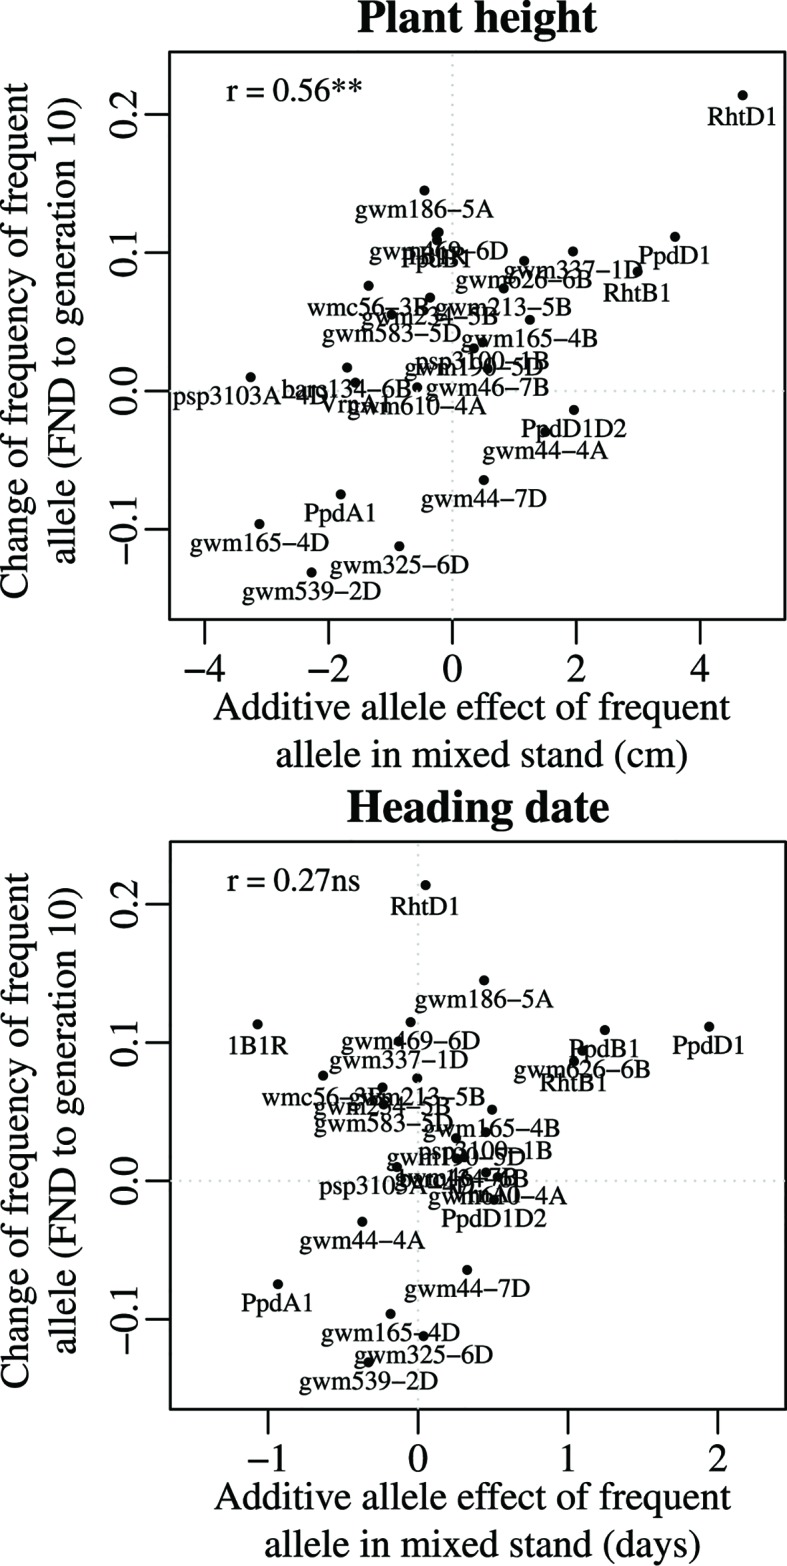
Relationship between the additive allele effect on plant height and on heading date and the temporal change in allele frequency from the virtual founding population (FND) to the allele frequency at generation 10 (averaged over all four locations). For plant height, the significant correlation indicates that those genes with a stronger effect on plant height (such as Rht-D1) tended to have a more pronounced selection over time, demonstrated by the high change in allele frequency.